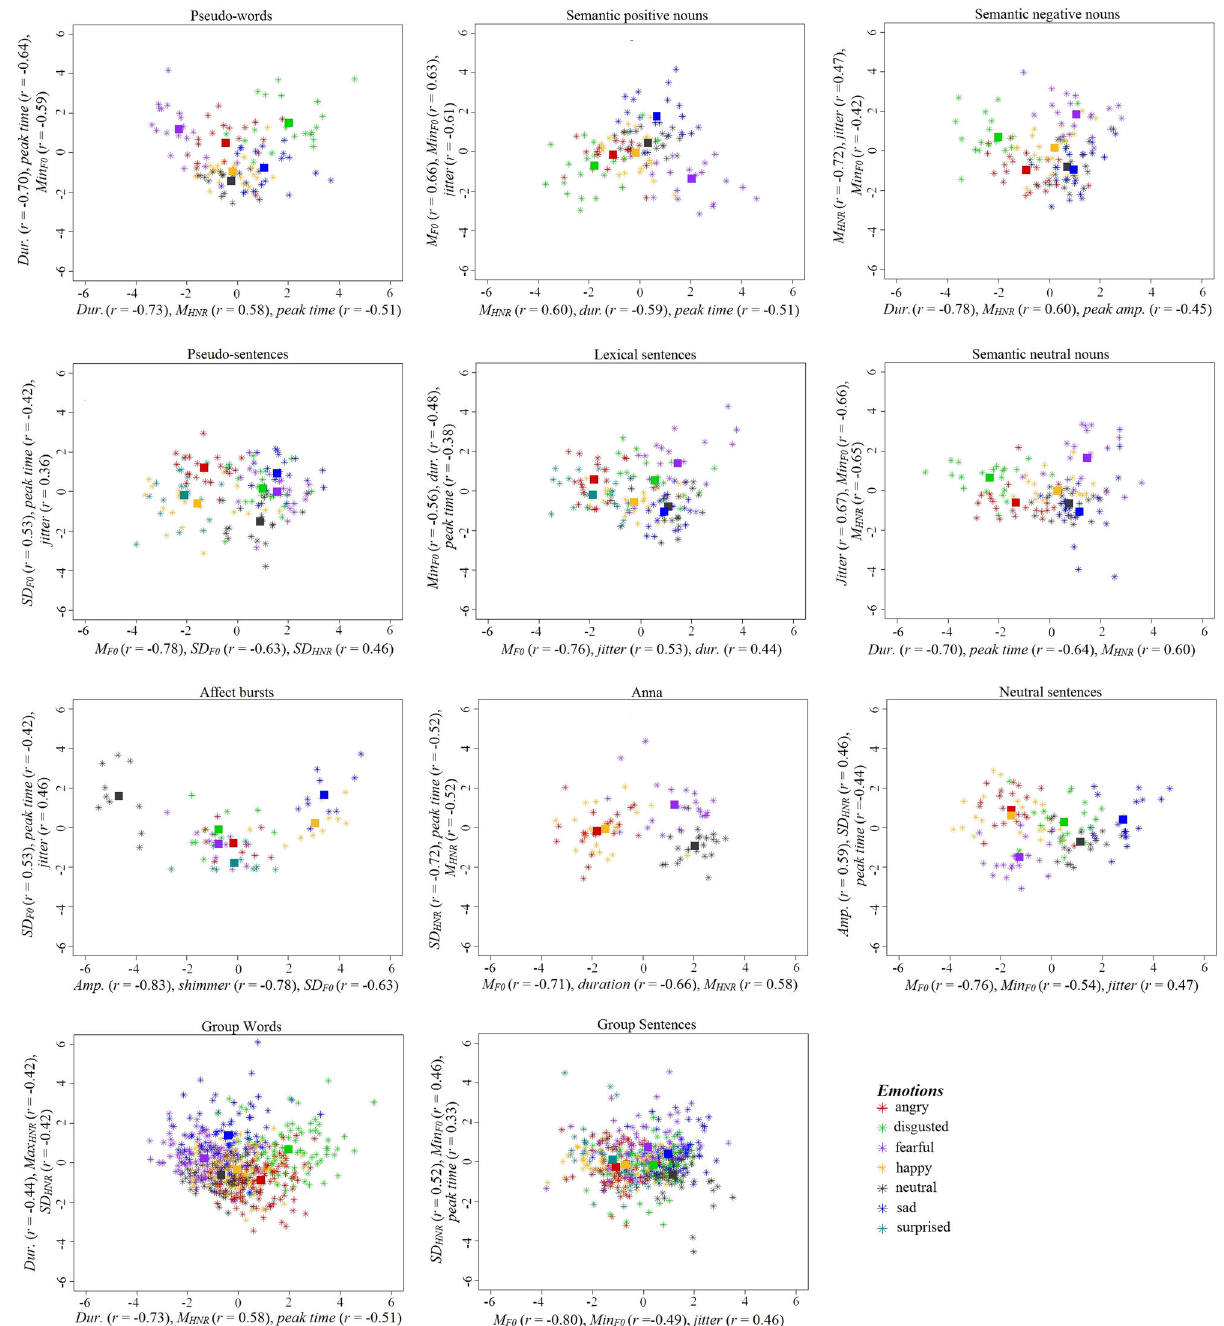
Fig. 1 Linear discriminant analysis for each- and across all stimuli. Each stimulus is plotted according to its scores for the discriminant function 1 and function 2. The squares represent the group means on each of the discriminant functions. On x- and y-axis are displayed the parameters that most strongly correlated with the fi rst two linear discriminant functions ( Min. = minimum; Max. = maximum; M = mean; SD = standard deviation; HNR = harmonics-to- noise ratio; F 0 = fundamental frequency; Dur . = duration; Amp. =